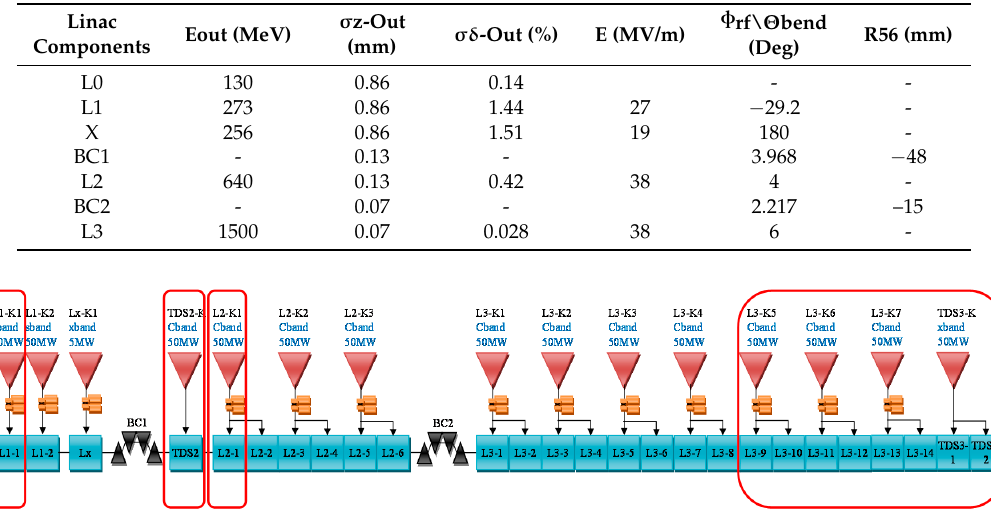
( d ) Figure 13. Simulation results of the electron beam distributions: energy distributions and current profiles at ( a ) injector exit; ( b ) BC1 exit; ( c ) BC2 exit and ( d ) L3 exit. 3.3. Undulator Lines and the FEL Performance There are two undulator lines for the user facility. One is upgraded from the test facility and will be operated with either a cascaded HGHG or EEHG-HGHG mode, as shown in Figure 14a, and